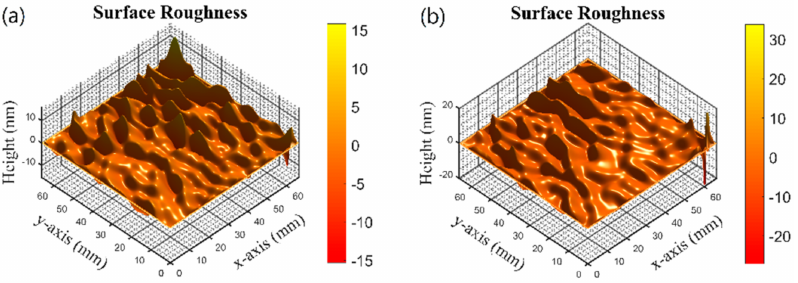
Figure 6. Surface roughness of ( a ) substrate before coating; ( b ) substrate after multilayer coating.